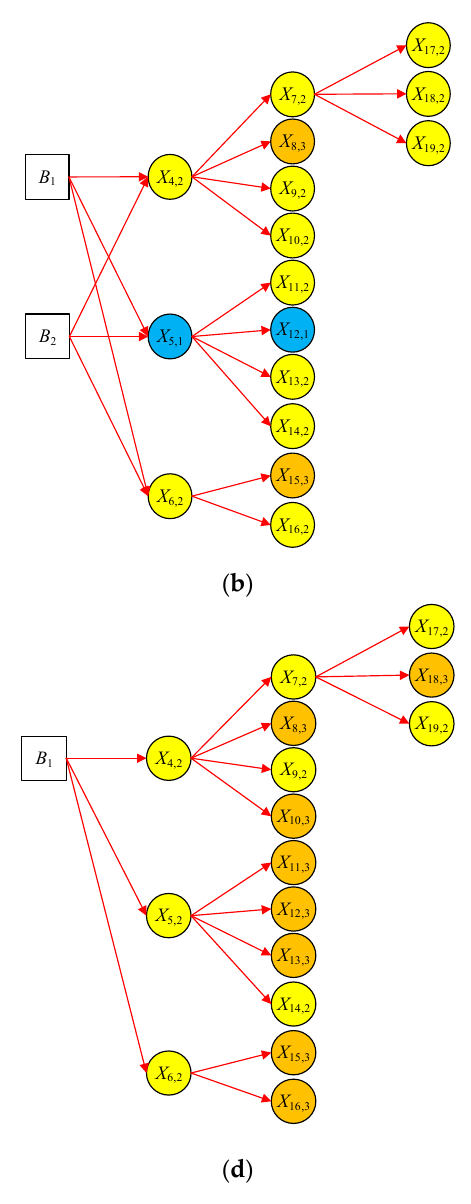
Figure 10. Simplified evaluation model of shale-gas sweet spots in ( a ) Changning with E 1 , ( b ) Weiyuan with E 2 , ( c ) Fushun- Yongchuan with E 3 , and ( d ) Jiaoshiba with E 4 .